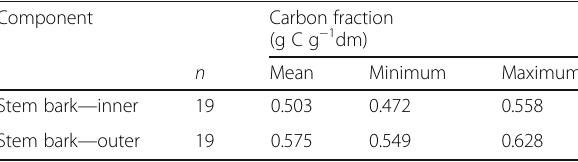
Table 3 Carbon fraction summary of inner and outer stem bark in 22/23-year-old radiata pine trees at Puruki Forest Component